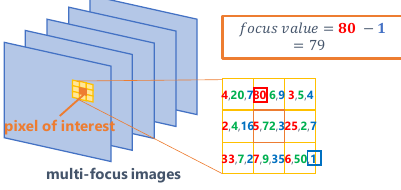
Figure 11. Focus value calculation